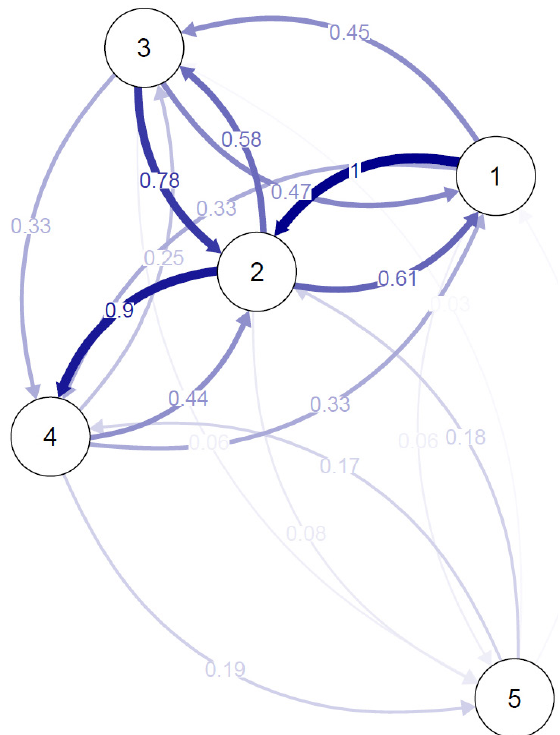
FIGURE 5 | Contemporary relative migration rates of Rhinoptera bonasus based on number effective of migrants ( Nm ) estimated from 5 microsatellite loci, estimated by divMigrate package. The arrows were weighted according to number of migrant values presented in S5 , and arrowheads show the estimated direction of gene flow. Collection areas: Santa Catarina (1), São Paulo (2), Rio de Janeiro (3), Pernambuco (4) and Pará